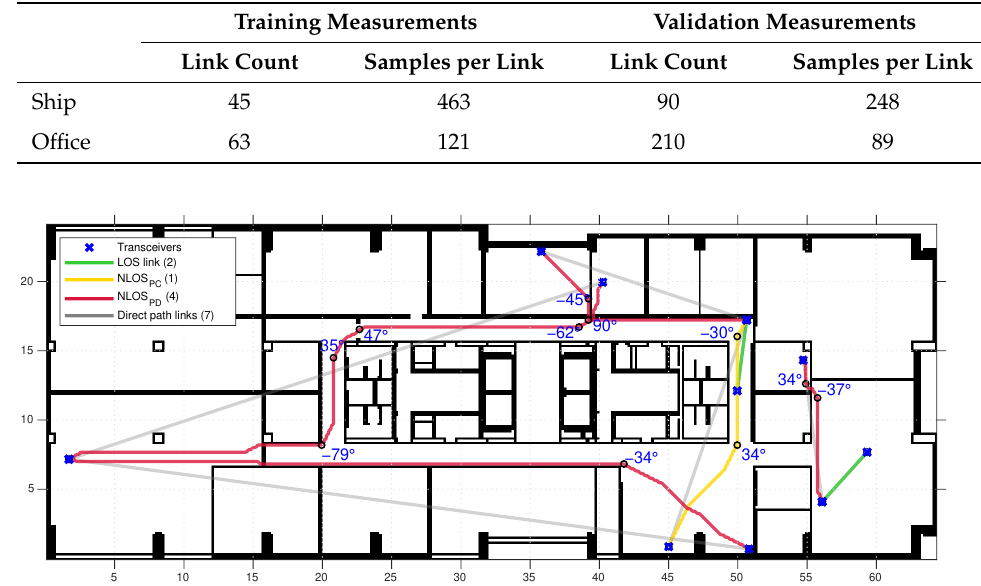
Figure 4. A visualization of the parameters produced by the algorithm, showing direction changes along the geodesic paths expressed in degrees, wall crossings by the direct paths and wall crossings by the geodesic paths. A randomly selected subset (approximately 3% of all links) is generated for